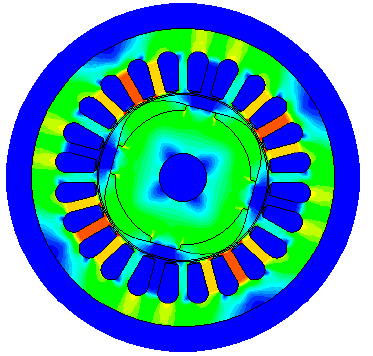
Figure 2. Magnetic Flux Density distribution.